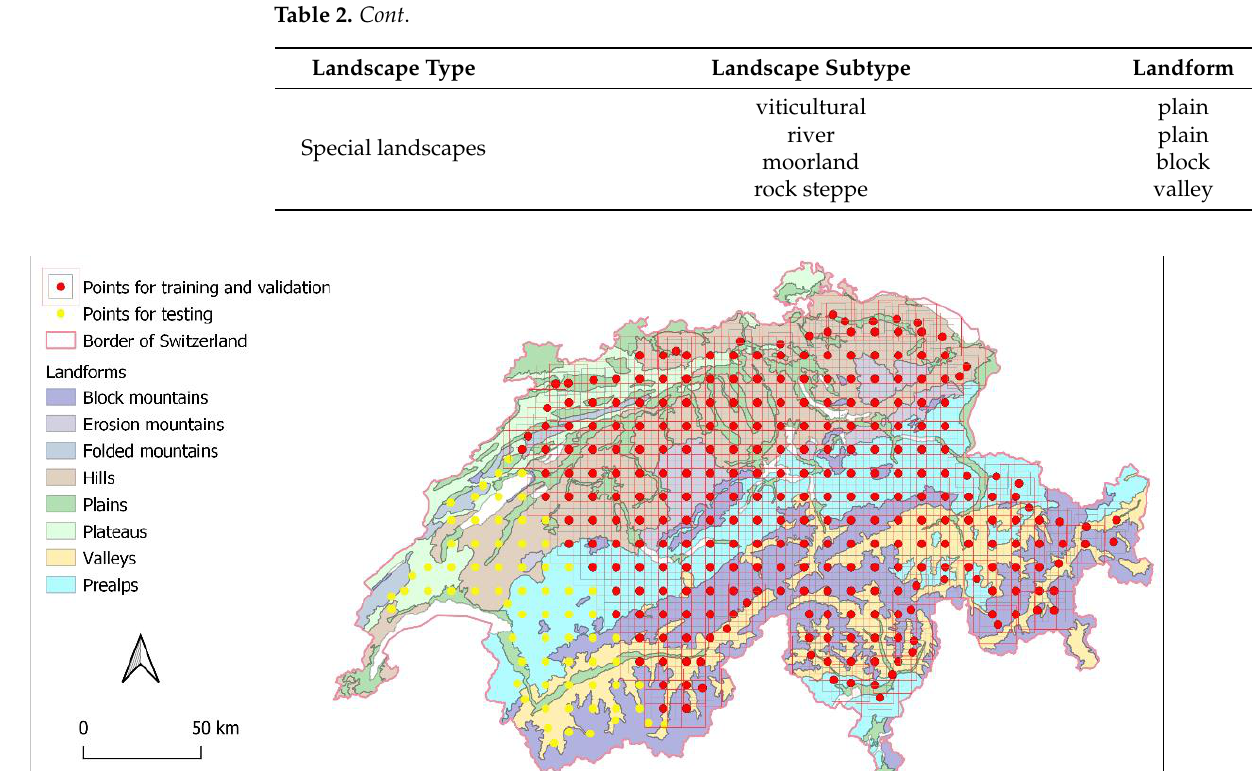
Figure 3. Landforms extracted from the landscape typology map with training points for training and validation, where both inner (grey) and outer (red) padding borders lie within the Swiss border. To provide the model with labels, we generated a 10 km grid of regularly distributed training points. Since the model would look as far as the padding areas, we had to make sure all the bounding boxes of 16 km (10 km and a padding of 3 km on both sides) fit completely within the Swiss border, i.e., where ground-truth data are present. For that reason, we manually moved close-to-the-border points away from the border and removed from the dataset those falling outside Switzerland. Out of 357 points, 80% (i.e., 286) of the points we choose for training and validation, while the other 20% of them will serve for the testing purposes (Figure 3). Diagonal cutting of the area ensures the presence of most of the landforms within both training and testing